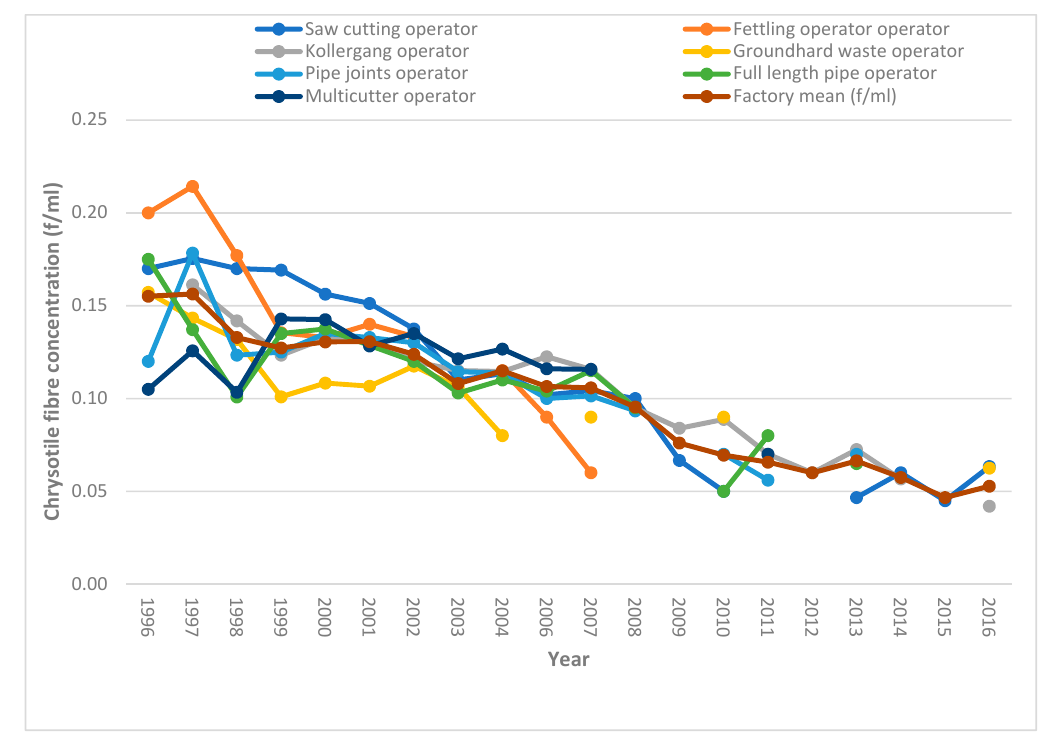
Figure 1. Changes in personal exposure chrysotile asbestos fibre concentrations from 1996 to 2016 for the Harare factory.